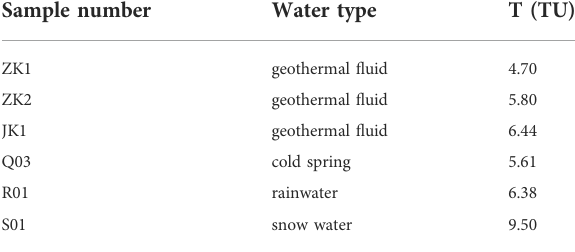
TABLE 5 T isotope test